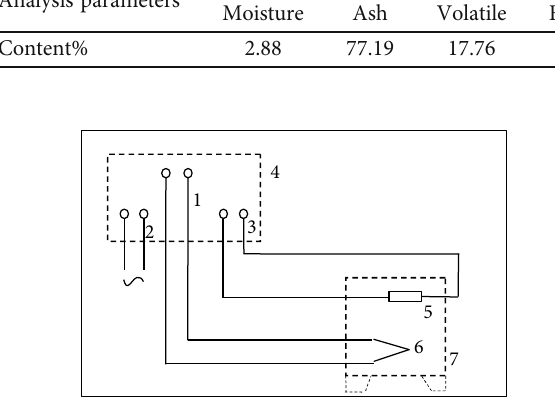
Figure 2: Mu ffl e furnace equipment. (1) Thermocouple. (2) Power supply. (3) Electric furnace. (4) Controller. (5) Electric heating element. (6) Thermocouple. (7) High-temperature electric furnace.